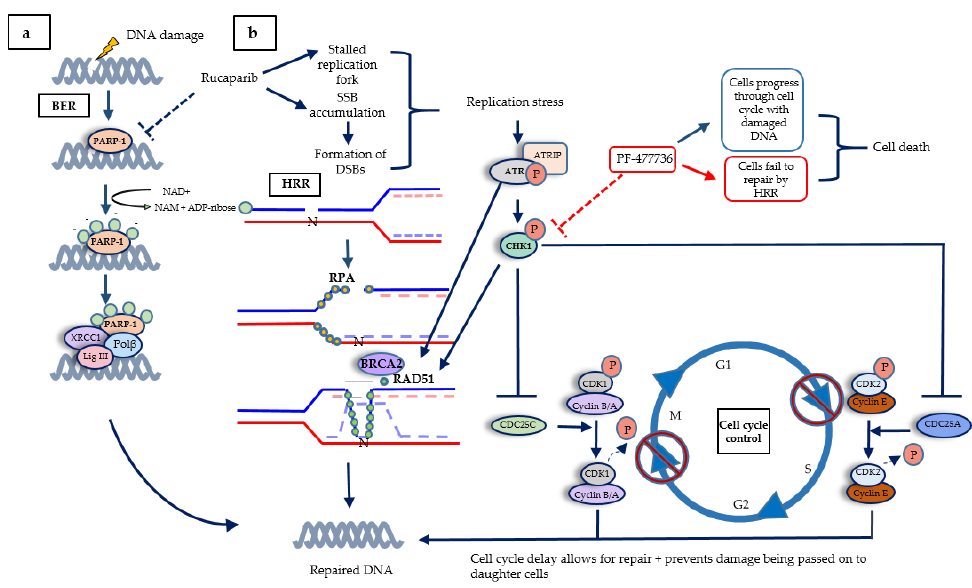
Figure 5. The DNA damage response, highlighting cross-talk between the cell cycle and DNA repair. ( a ) Base excision repair (BER) is the first line of defence when DNA damage occurs. PARP activation by SSB recruits XRCC1, Pol β, and Lig III to repair the DNA. ( b ) When PARP is inhibited, SSB